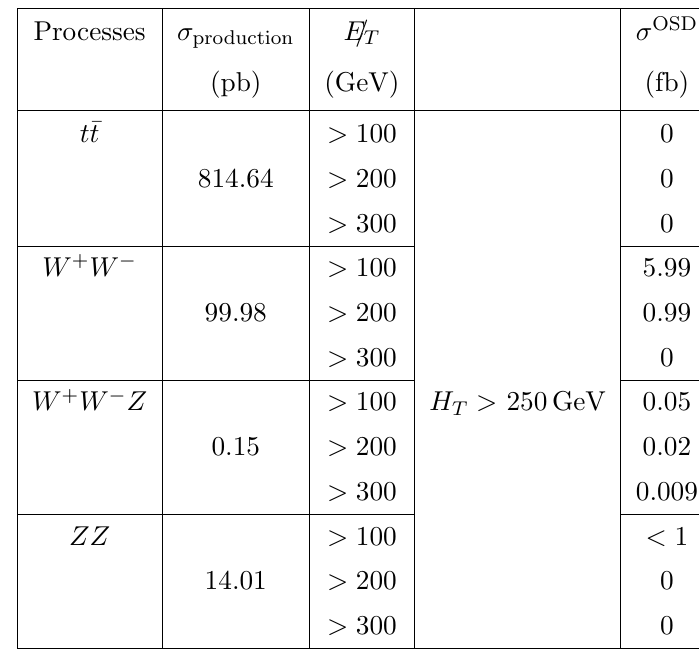
Table 5 . Variation of (cid:12)nal state SM background cross-section with MET cut for a (cid:12)xed cut on H T > 250 GeV. All simulations are done at